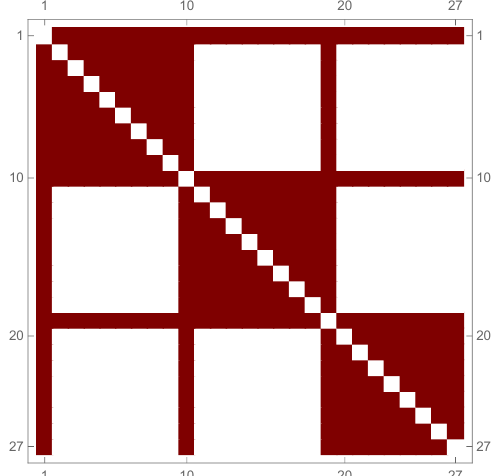
Figure 1 . Matrix of Mandelstam invariants s ab for the n = 27 split kinematics (1 , 10 , 19) , having set to zero all s ab ’s in the unshaded